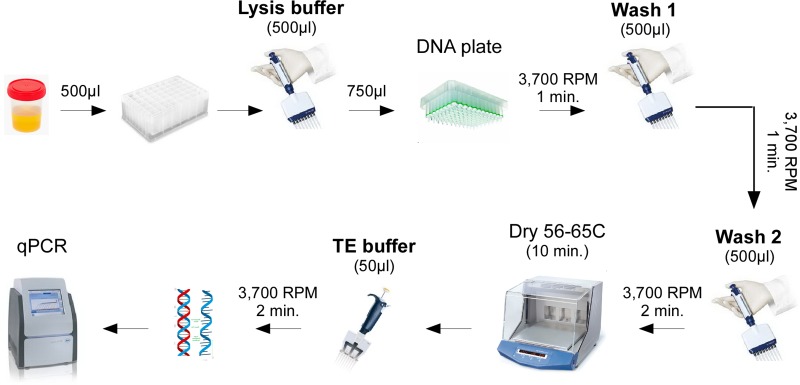
A schematic representation of the protocol.The complete protocol can be found in S1 Appendix and a list of consumables in S1 Table.